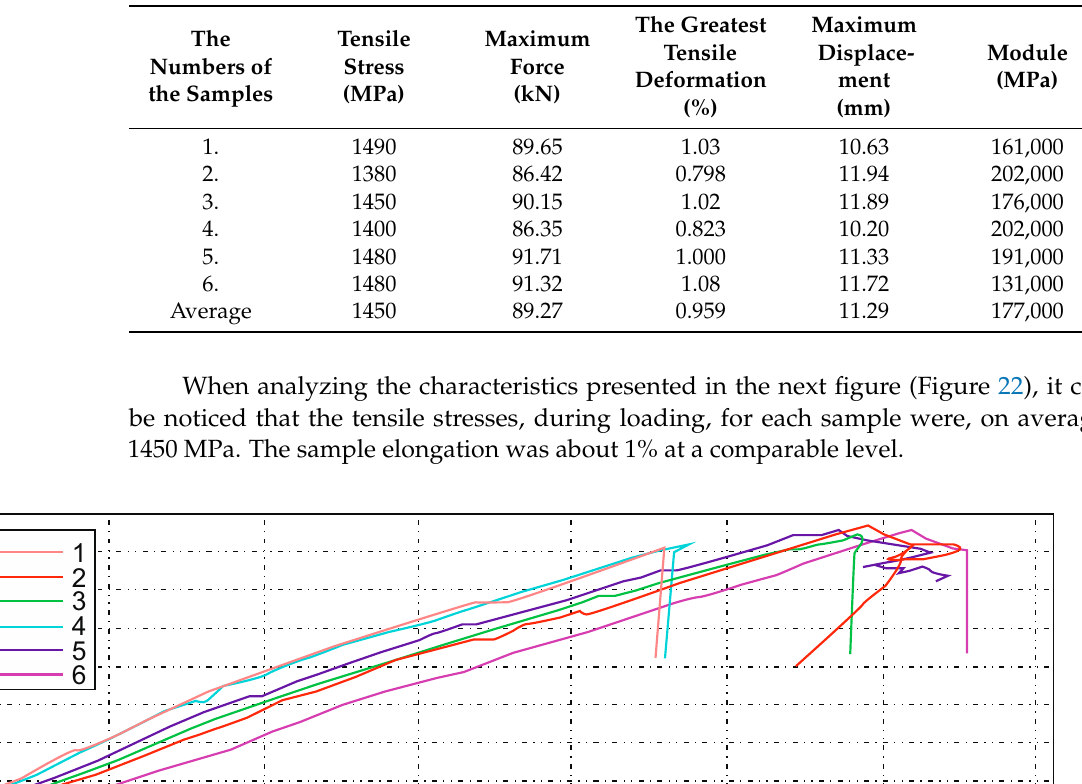
Table 9. Analysis of the obtained test results for a composite laminate reinforced with IMS65 modular fabric, 0/90 ◦ configuration.